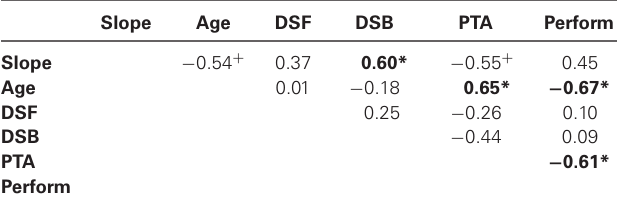
Table 1 | Spearman’s correlations between behavioral measures .